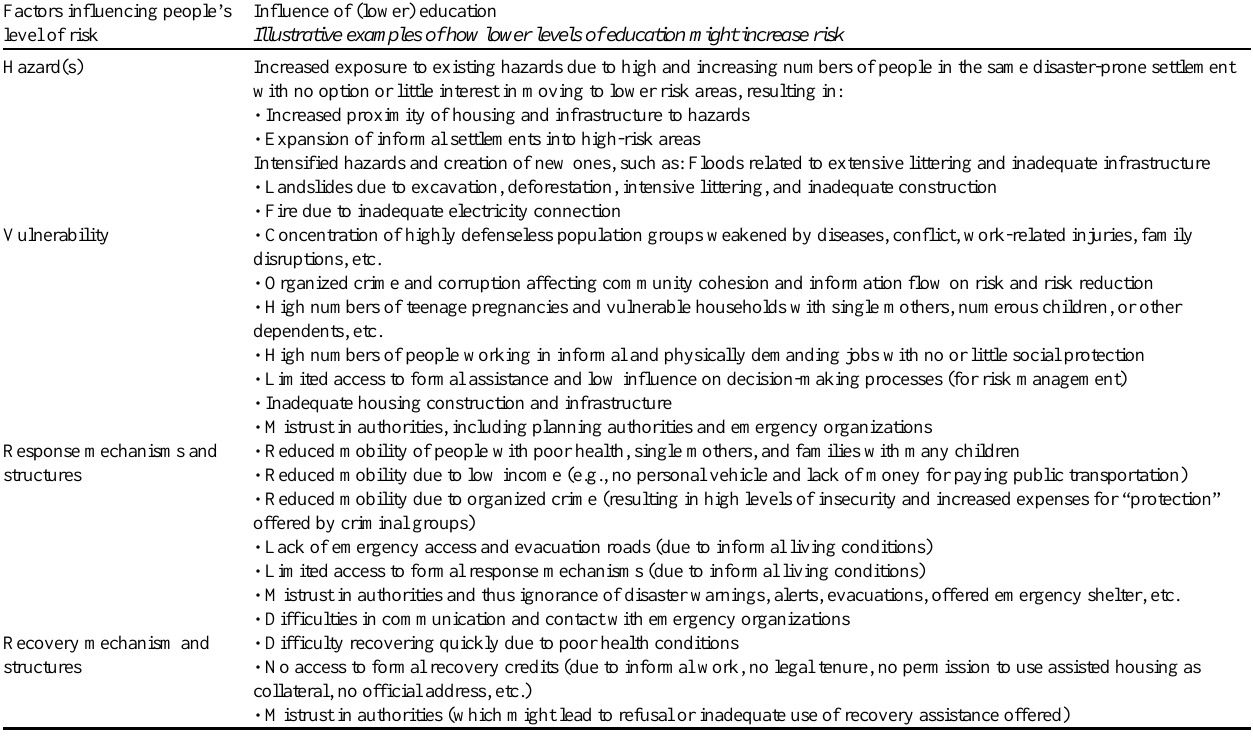
Table 3. Influence of education on existing area-specific risk Factors influencing people’s level of